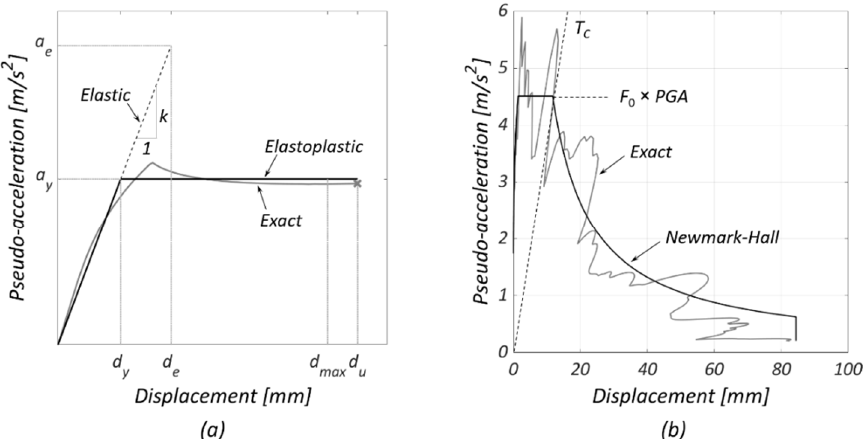
Figure 1. Oscillators and input ground motions for nonlinear time-history analyses (NLTHA): ( a ) elastoplastic idealization of monotonic acceleration-displacement (AD) response (adapted from [44]); ( b ) elastic response spectra in AD format of the Niijima Island earthquake (July 1, 2000).